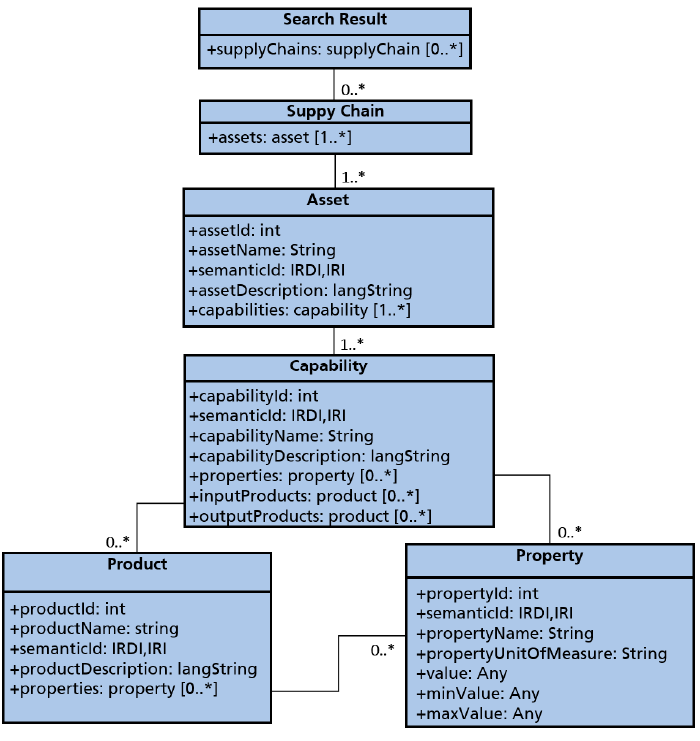
Figure 11. Search result specification.